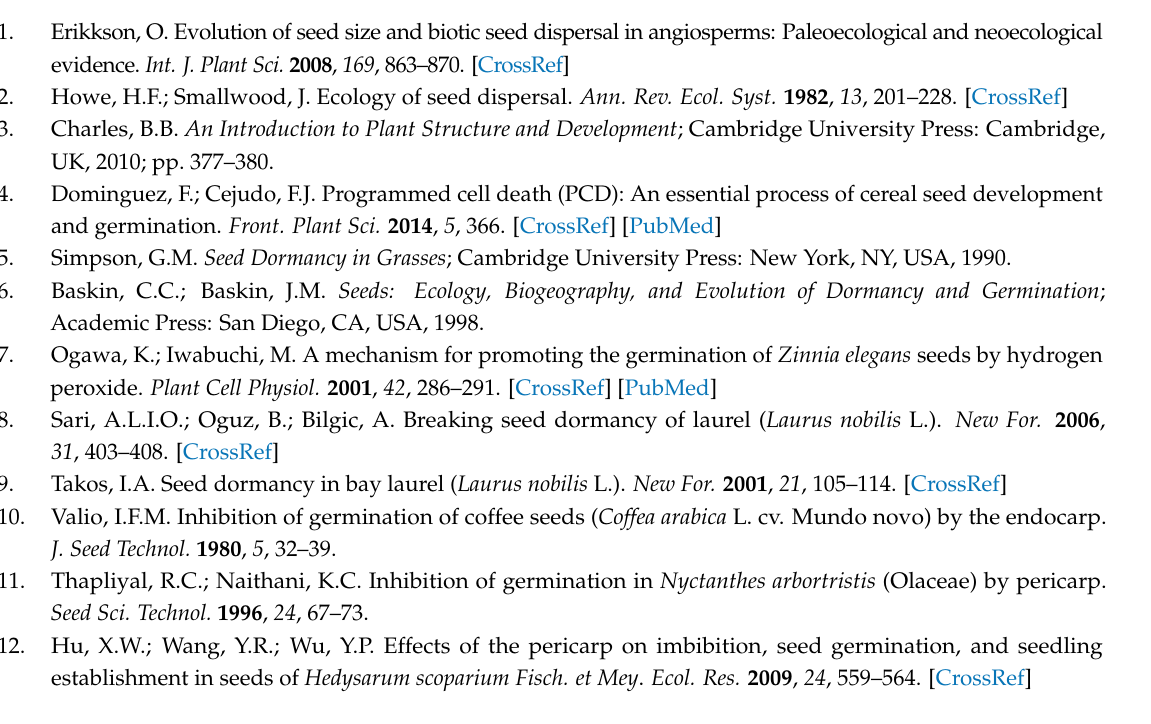
Supplemental Data 1: Figure S1. Dynamics of nuclease release from the dead pericarps. Figure S2. Nutrient analysis of A. thaliana pericarps. Figure S3. Field germination experiments. Figure S4. Effect of S. alba pericarp extract on B. rapa seed germination. Table S1. List of plant species used in this study. Table S2. Pectinesterases and polygalacturonases released from S. Alba indehiscent pericarps (proteome analysis). Table S3. ROS detoxifying enzymes released from S. Alba indehiscent pericarps upon hydration (proteome analysis). Supplemental data 2. Proteome raw data of proteins released from S. alba indehiscent